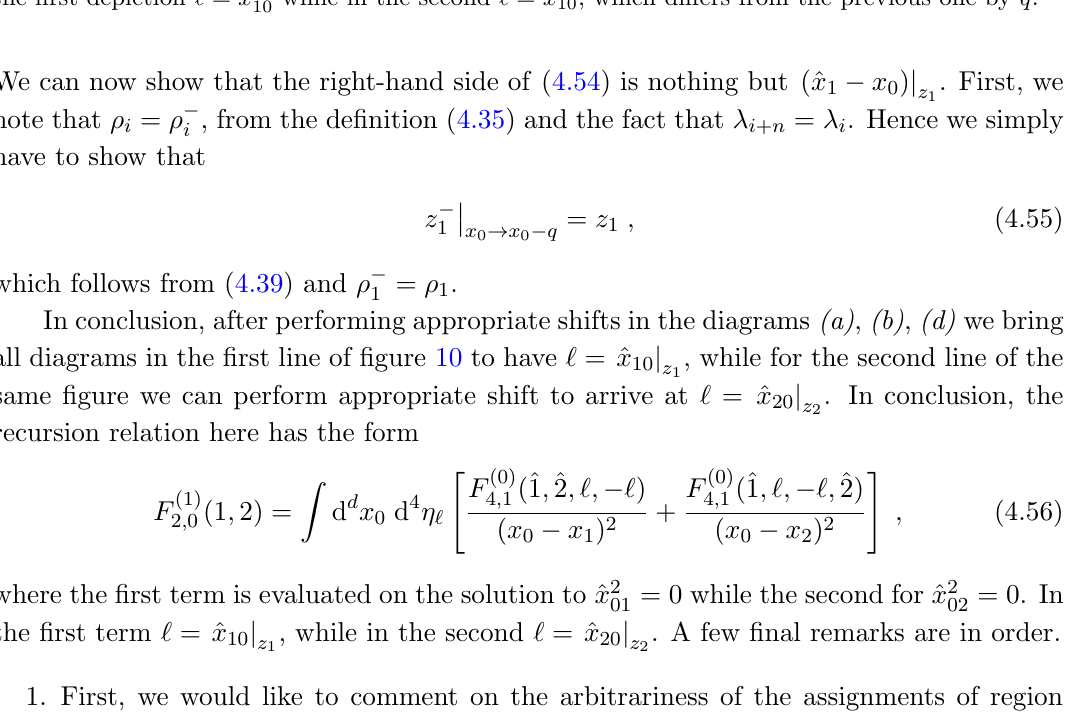
(cid:0) x ) j . First, we 1 0 z 1 = (cid:21) . Hence we simply i + n i